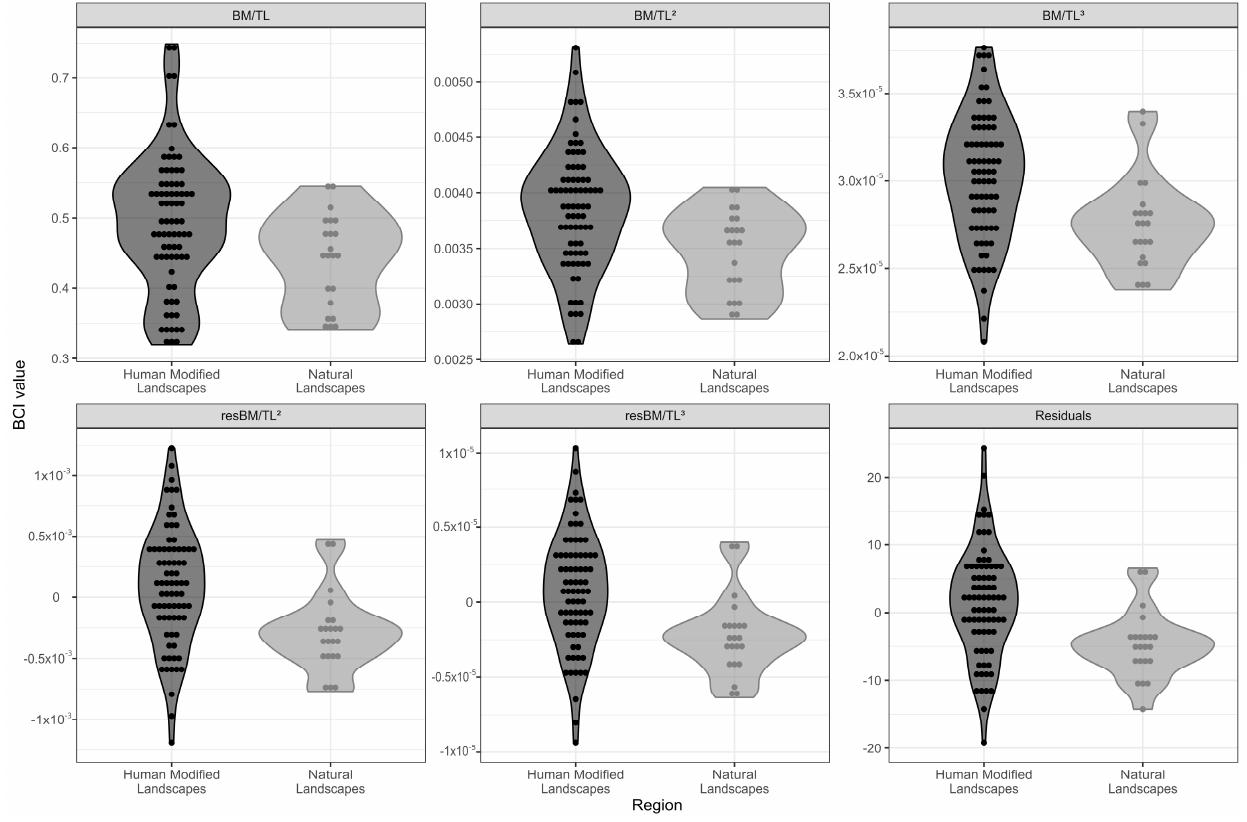
Figure 5. Graphical representation of individual values of five types of Body Condition Index (BCI) for adult capybaras, according to the study region (human-modified landscapes and natural landscapes).